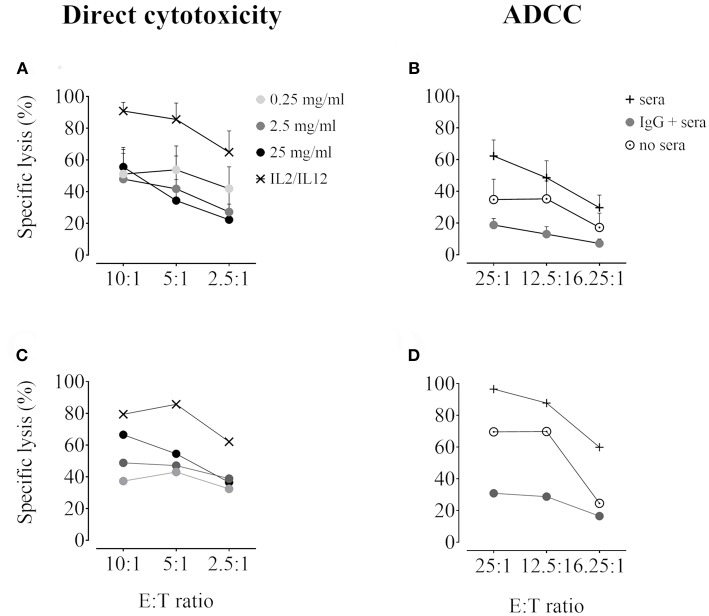
Inhibition of direct NK cytotoxicity and ADCC by IVIg. Purified human NK cells were incubated overnight with IL2 (50 U/ml) and IL12 (0.5 ng/ml) in the presence or not of IVIg (0.25–25 mg/ml). Vehicle was used as an internal control (data not shown). NK cytotoxicity was tested using DELFIA cytotoxicity assays. (A) and (C) Direct NK cytotoxicity: NK cells and BATDA-labeled K562 targets were plated at different E:T ratios (10:1, 5:1, and 2.5:1) for 2 h. (B,D) ADCC: BATDA-labeled PED target cells (pre-incubated or not for 45 min with 10% human serum) were plated at different E:T ratios (25:1, 12.5:1, and 6.25:1) for 2 h with IVIg (2.5 mg/ml). In both assays, EuTDA-release was measured by time-resolved fluorometry. Data are presented as specific lysis plots, in (A,B) as pooled data (n = 6 for direct cytotoxicity, n = 5 for ADCC), and in (C,D) as a single donor representative experiment.